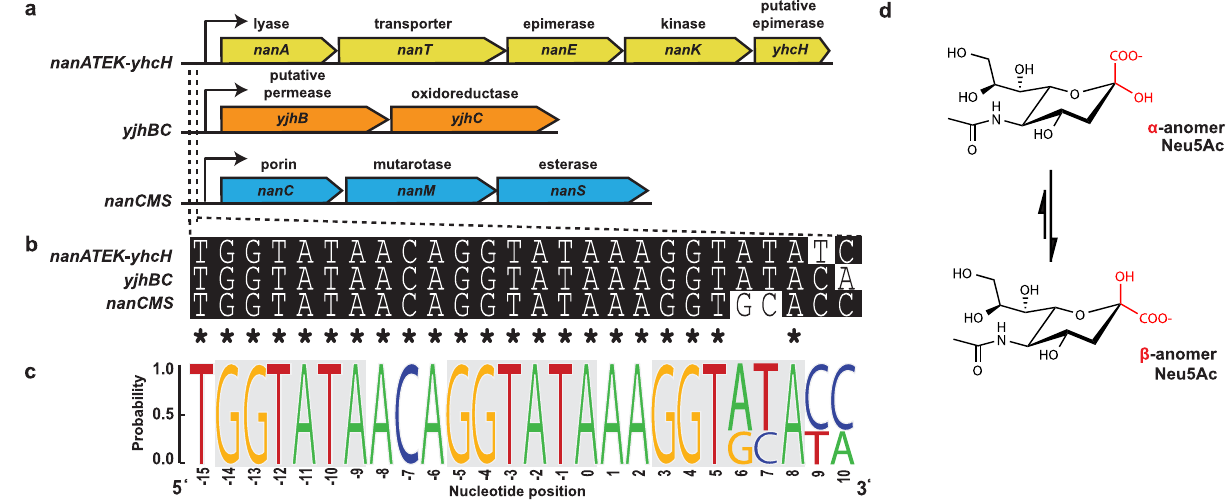
Fig. 1 NanR binds a conserved operator site in three distinct operons. a The sialoregulon consists of: nanATEK-yhcH (yellow), which is the core sialic acid catabolic pathway 18,21 ; yjhBC (orange), which encodes proteins of unknown function that are hypothesized to process less common variants of sialic acid 18,85 ; and nanCMS (blue), which is responsible for outer membrane transport and periplasmic processing 86 – 88 . b Sequence alignment of the operator sites present in each operon. Conserved nucleotides are marked with an asterisk. c Sequence logo highlights the conservation of the DNA bases within these operator sites (generated using WebLogo). The repeat sequence is shown in gray boxes. d The most common sialic acid, Neu5Ac, is shown in the chair conformation. The α -anomer and thermodynamically favorable β -anomer differ by the stereochemistry at the C2 position, highlighted in